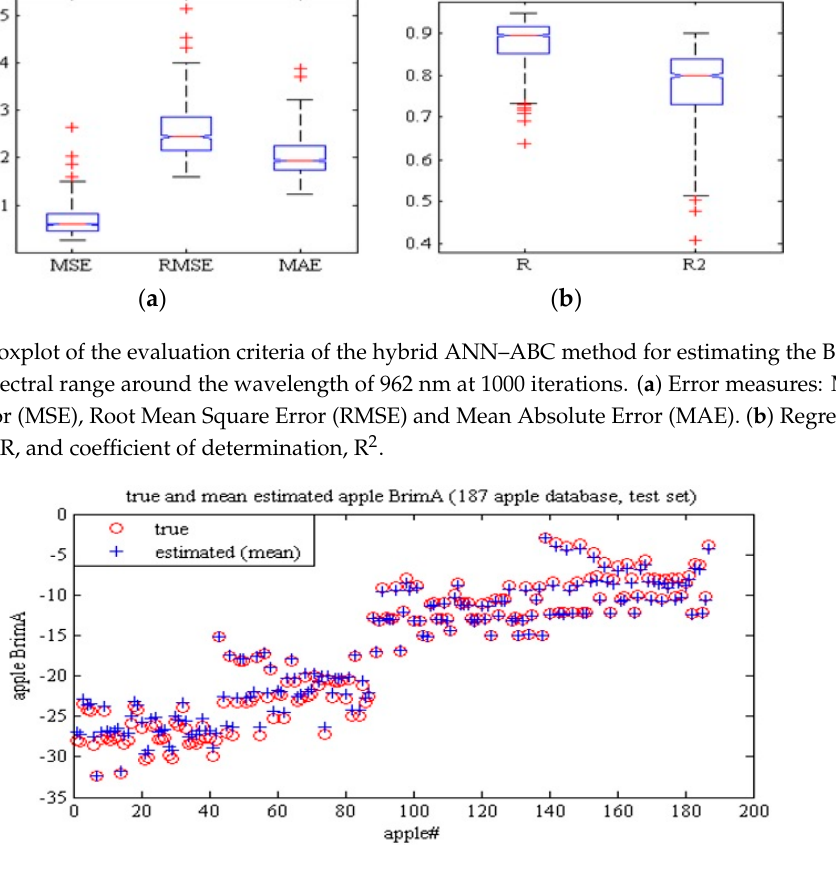
Table 4. Mean and standard deviation of the performance evaluation parameters of the hybrid ANN– ABC method in estimating apple firmness on the spectral data around the wavelength range from 875 nm at 1000 iterations.